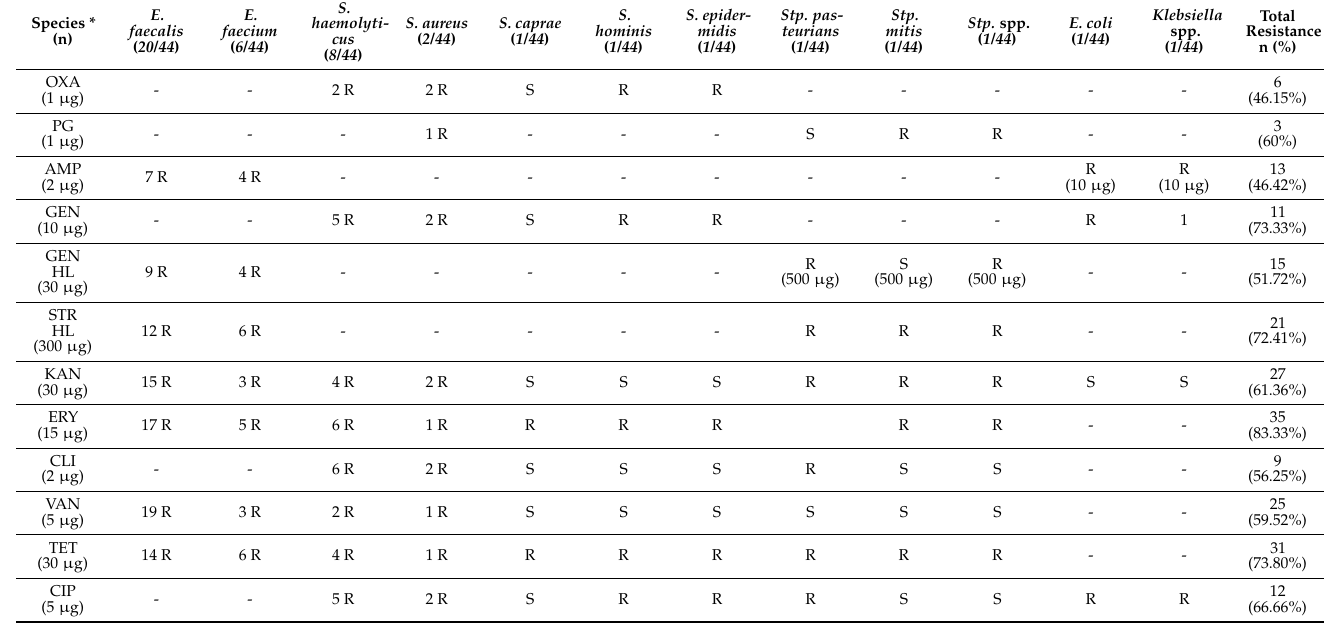
Table 5. Antibiotic pattern profiles of all strains of bacteria (n = 44) isolated from RPL